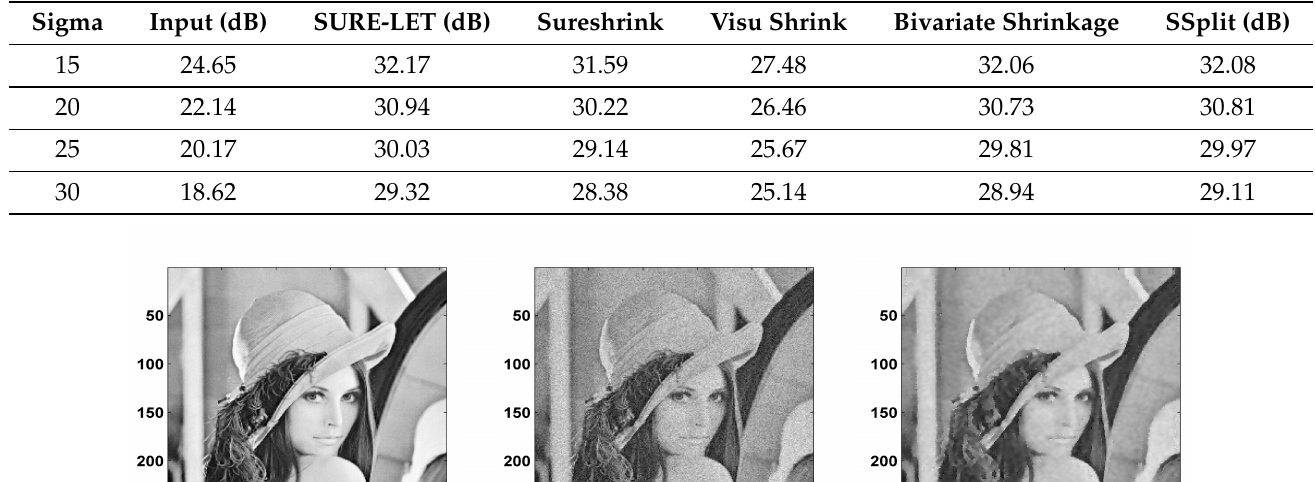
Table 2. PSNR values for Lena test images with different noise levels and denoised with: the SURE LET, SureShrink, VisuShrink, Bivariate shrinkage function, and SSplit methods.